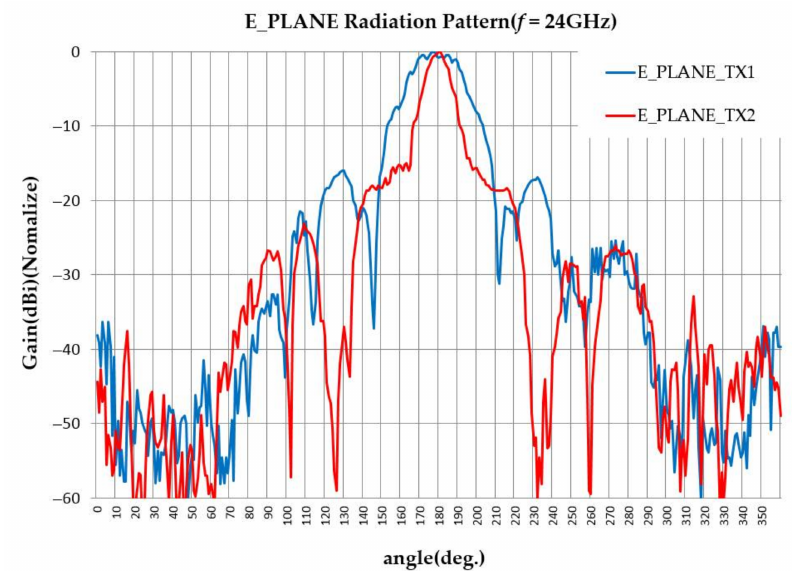
Figure 5. Measured transmission radiation pattern (normalized).